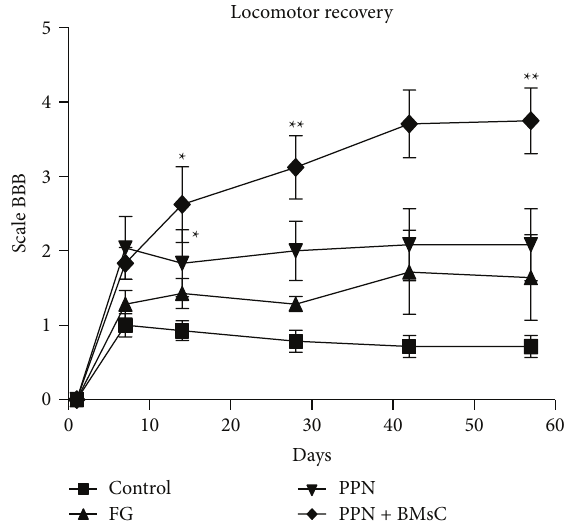
Figure 2: Analysis of locomotor function based on the BBB rating scale. 𝑦 -axis corresponds to days of evaluation, where day 0 was the beginning of the evaluation within 24 hours after the transplant. The differences between the PPN and PPN + BMSCs groups can be observed when compared to the Control group (*) (Kruskal-Wallis test, 𝑝 < 0.05 ); furthermore, upon comparing the treatment groups, only the PPN + BMSCs group presented a significant difference from day 30 onwards compared to FG (**) (Kruskal-Wallis test and Mann-Whitney 𝑈 Test, 𝑝 < 0.05 resp.), with no difference observed between the transplant groups. The graph represents the average ± standard